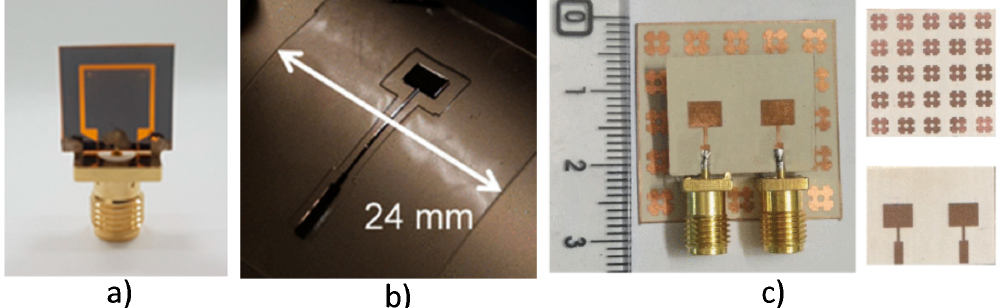
Figure 11. Flexible antennas for applications above 12 GHz. ( a ) Graphene antenna prototype for 5G applications [179], ( b ) millimeter-wave planar antenna prototype on PDMS substrate [185], and ( c ) electromagnetic bandgap (EBG) backed millimeter-wave multiple-input-multiple-output